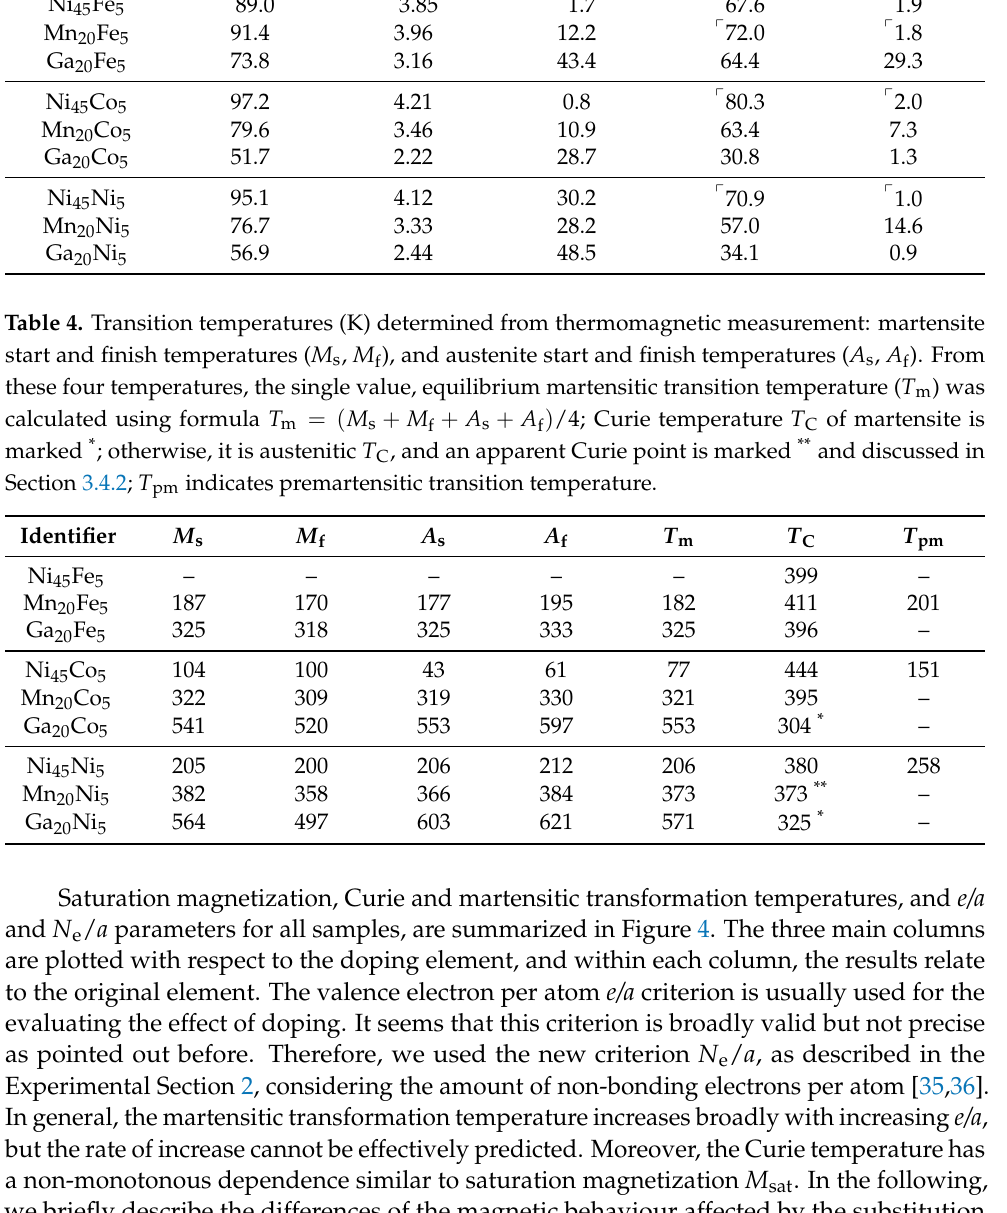
Table 3. Parameters determined from magnetization curves: saturation magnetization M sat at 10 K and 300 K at 9 T; coercive force µ 0 H C at 10 K and 300 K. The values corresponding to austenitic phase are marked by upper-left corner symbol (cid:112) .